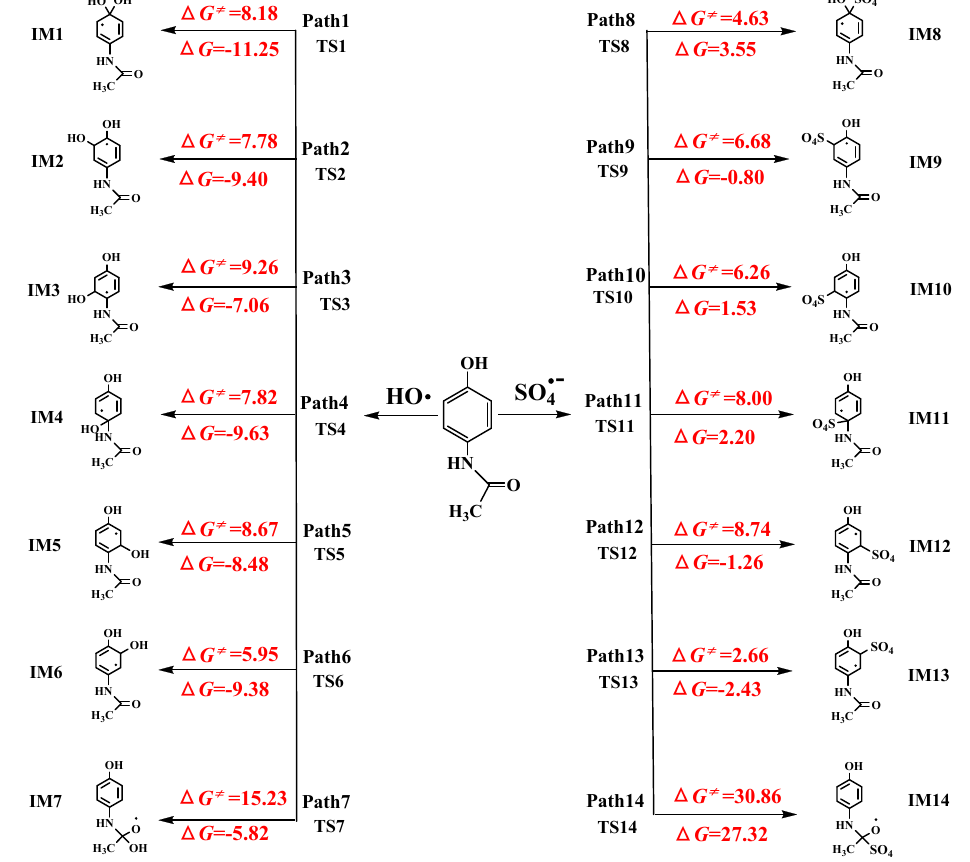
Figure 2. The radical adduct formation channels of AAP with •OH and SO 4• − reactions with the Gibbs free energy of reaction ( Δ G ) and Gibbs free energy barrier of activation ( Δ G ≠ ) (unit: kcal/mol).